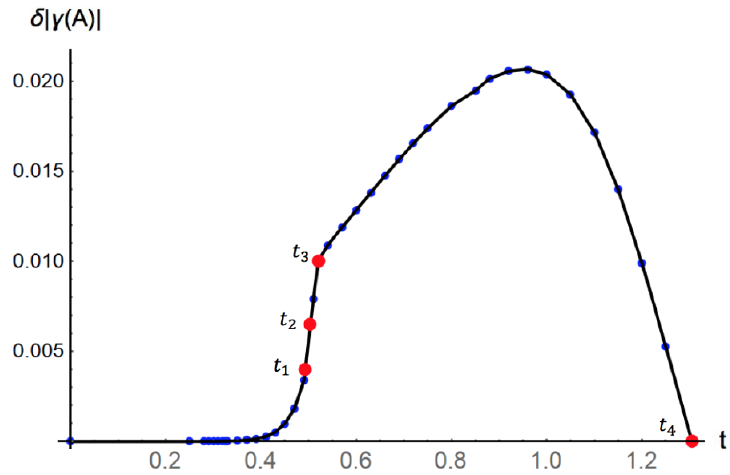
Figure 9. (cid:14) j (cid:13) ( A ) j = j (cid:13) ( A ) j (cid:0) j (cid:13) R ( A ) j as a function of time.